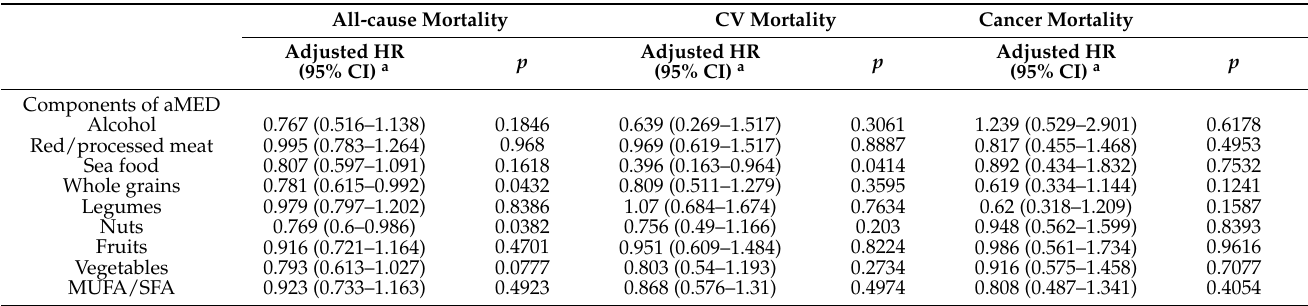
Table 3. Associations of individual food components of the Mediterranean-style diet with all-cause, cardiovascular and cancer mortality in NHANES participants with history of coronary heart disease or stroke.